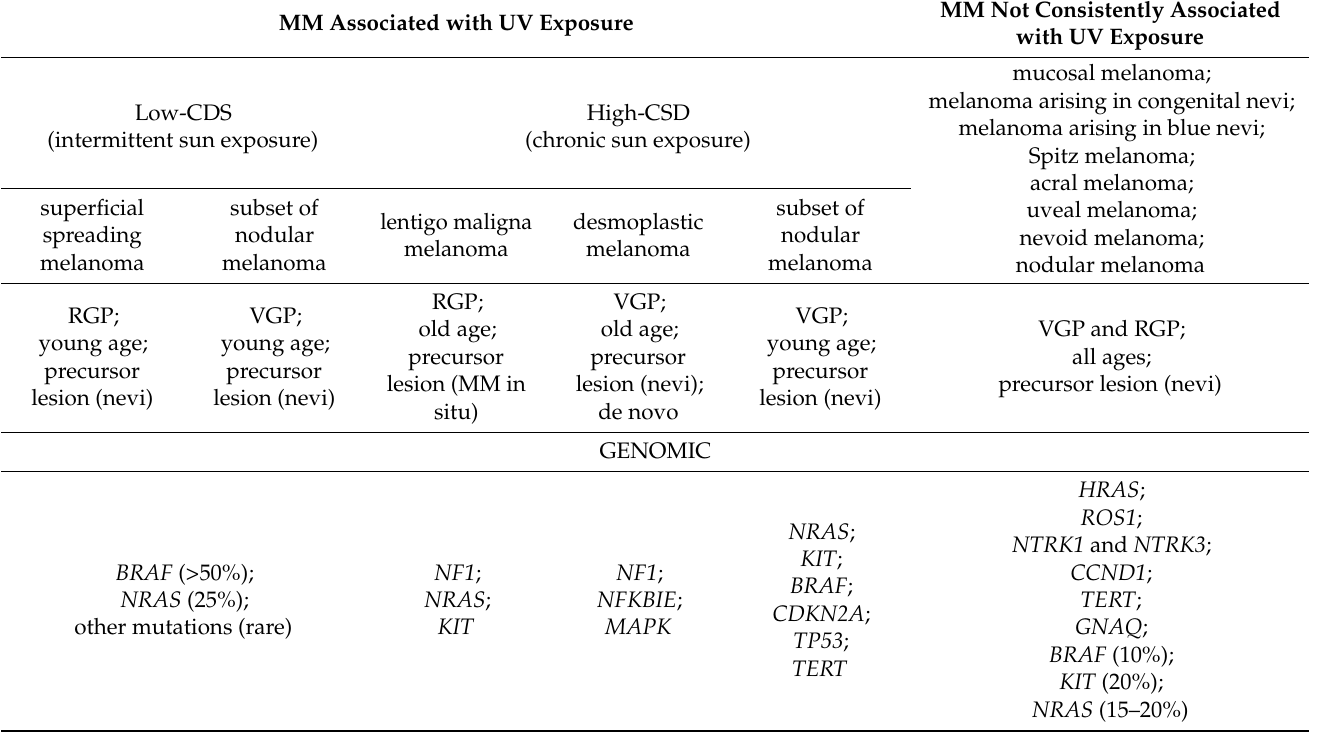
Table 1. Malignant melanoma classification according to sun exposure, general features, and types of gene